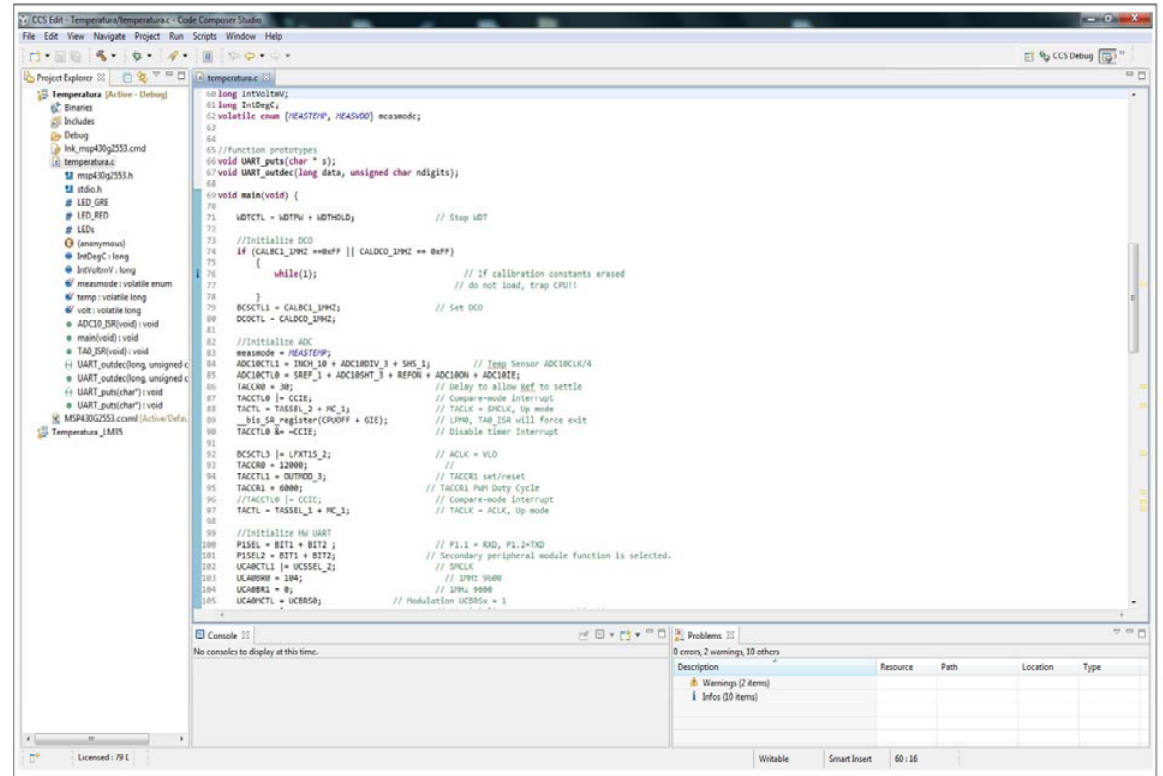
Figure 4. Code Composer Studio v5